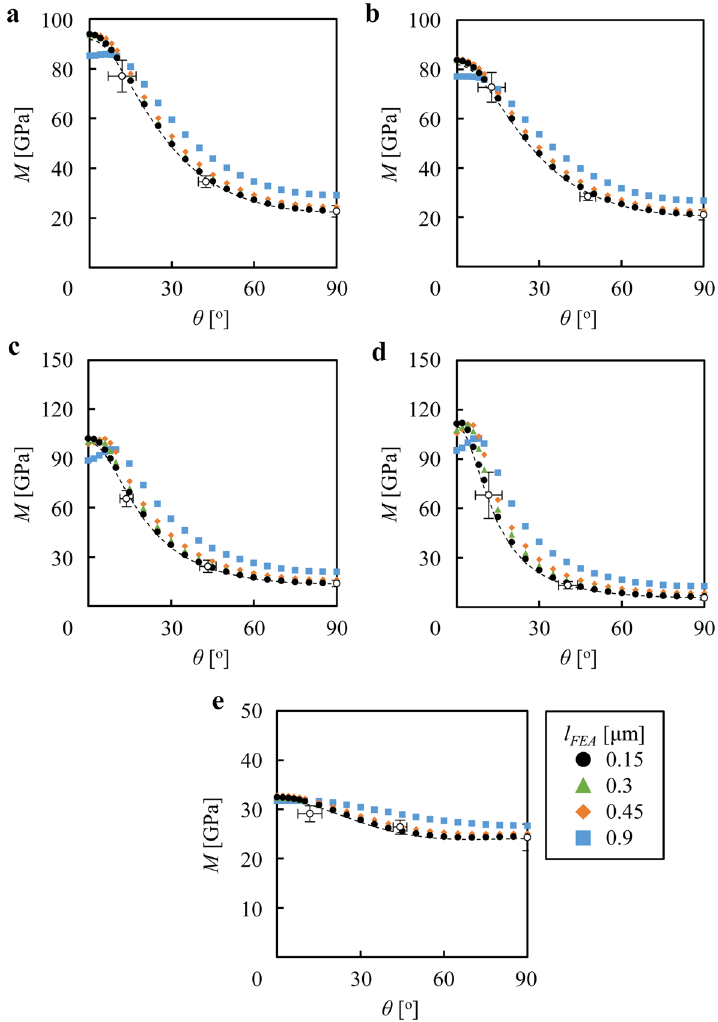
Fig. 6 Indentation-derived elastic modulus ( M ) values at various tilt angles ( θ ) and mesh sizes ( l ) calculated using FEA finite element analysis for commercially available carbon fibers a T800SC, b T700SC, c M60JB, d K13D, and e XN05. The dotted lines represent values calculated using the VN model ( n = 1000), and open VN circles show experimental results